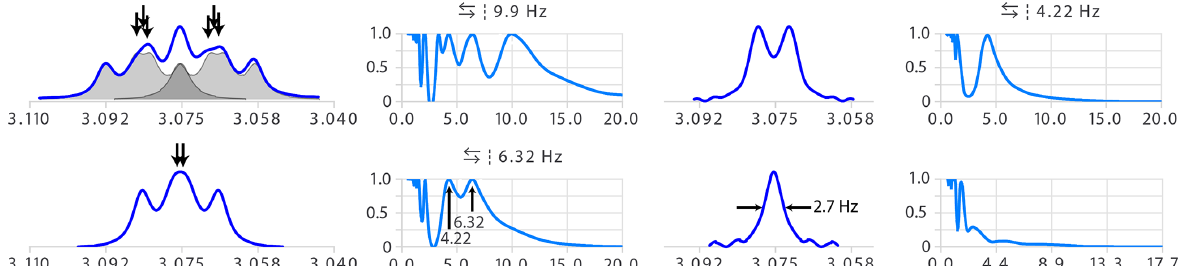
Figure 9. Example of a ddd structure analysed straightforwardly by multiplet deconvolution. The symbol indicates that symmetrization was applied before deconvolution. The symbol indicates that the results of the deconvolution running from both sides were added (instead of taking the best part of both of each or only the result of one